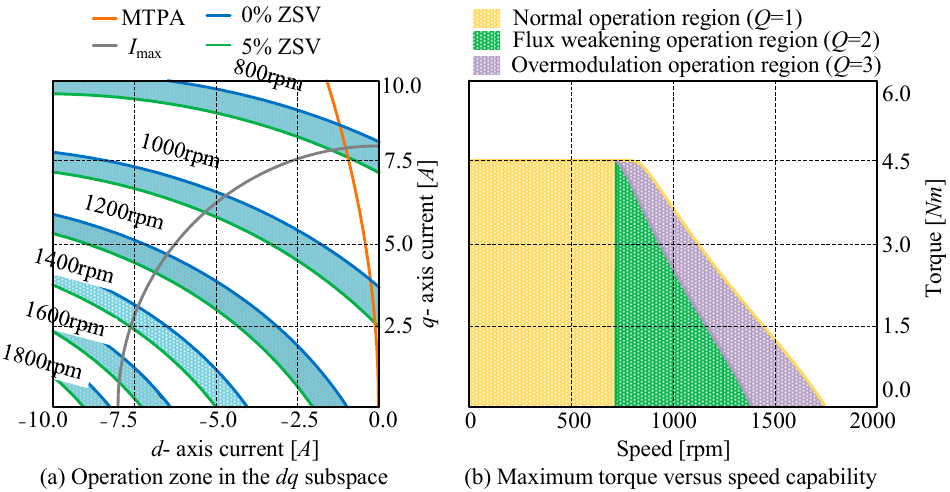
Figure 10. Operation region comparison.